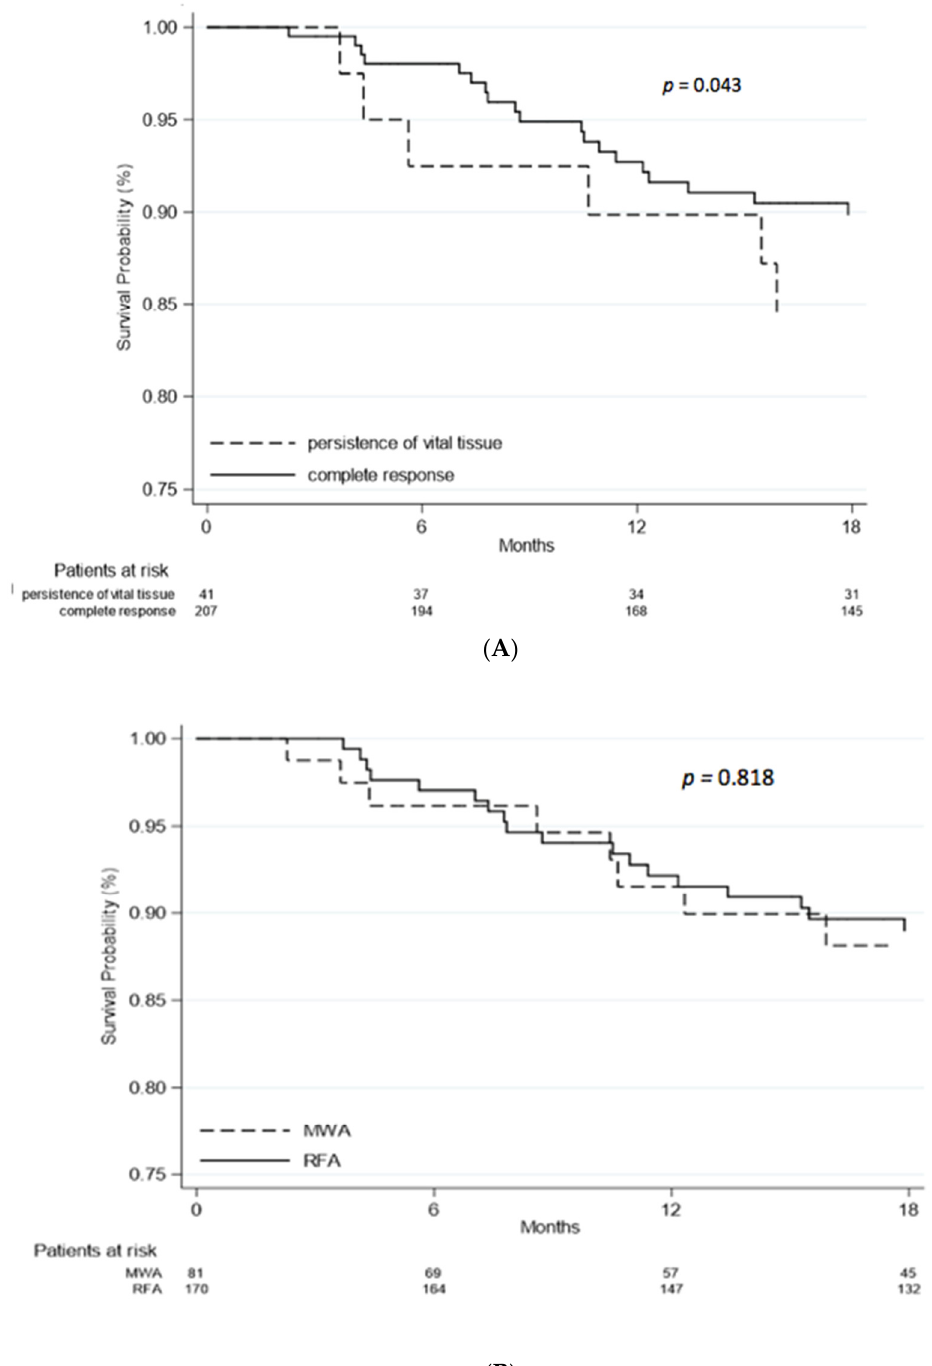
Figure 3. ( A ), Overall survival; ( B ), Overall survival by treatment. Demographic features of patients at baseline, alfa-fetoprotein value at diagnosis and type of therapy were not related to survival rate ( p > 0.05). Patients who underwent liver transplantation after thermal ablation had a better survival rate compared to the others (HR = 0.19; 95%CI 0.06–0.57, p =